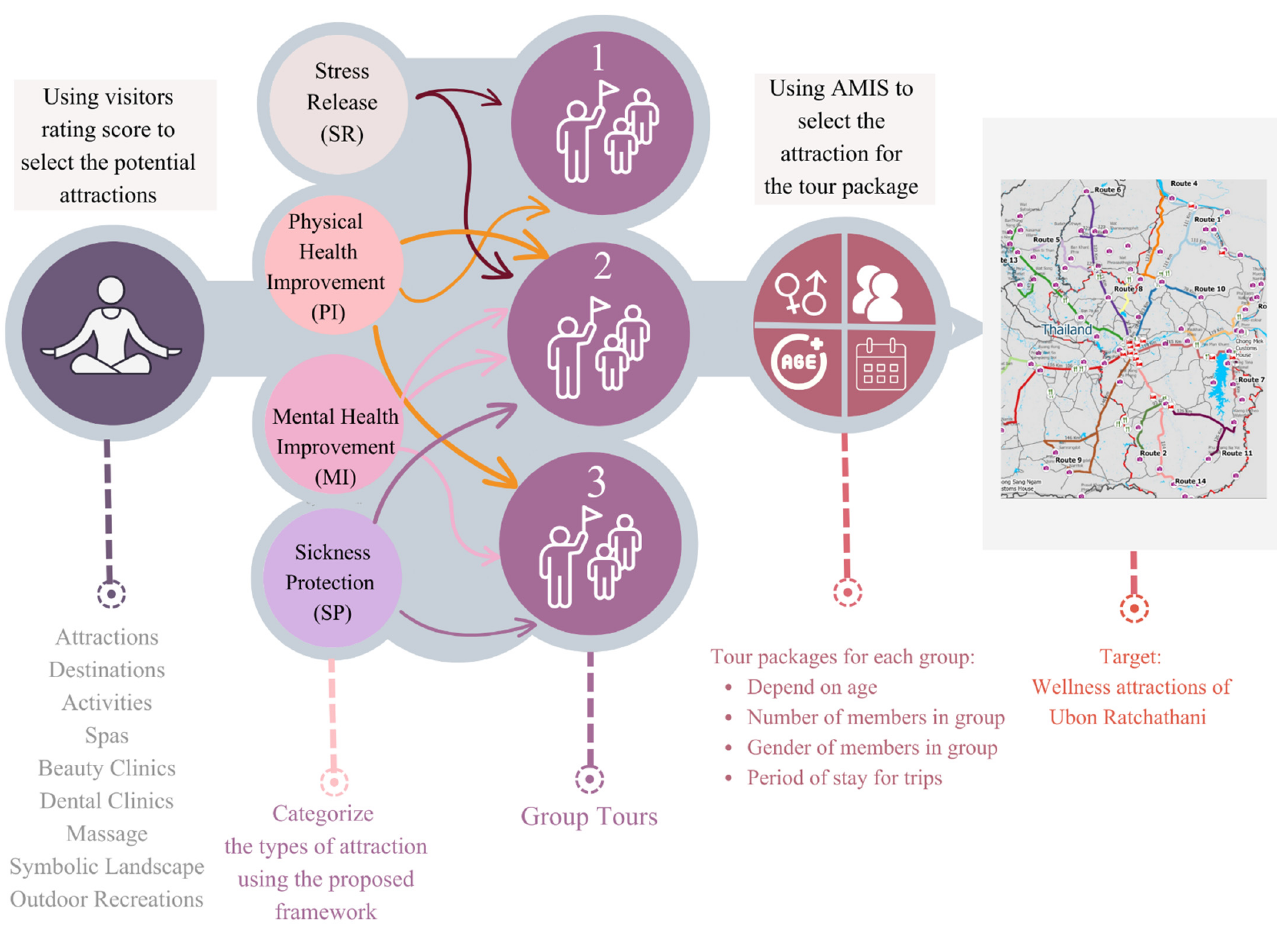
Figure 2. Framework of the proposed.